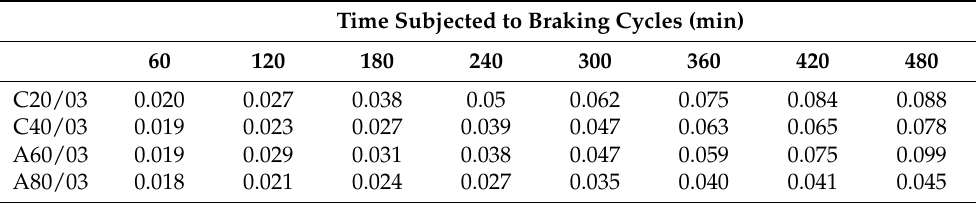
Table 8. Weight loss (g) of brake pads with ELT rubber particles of different